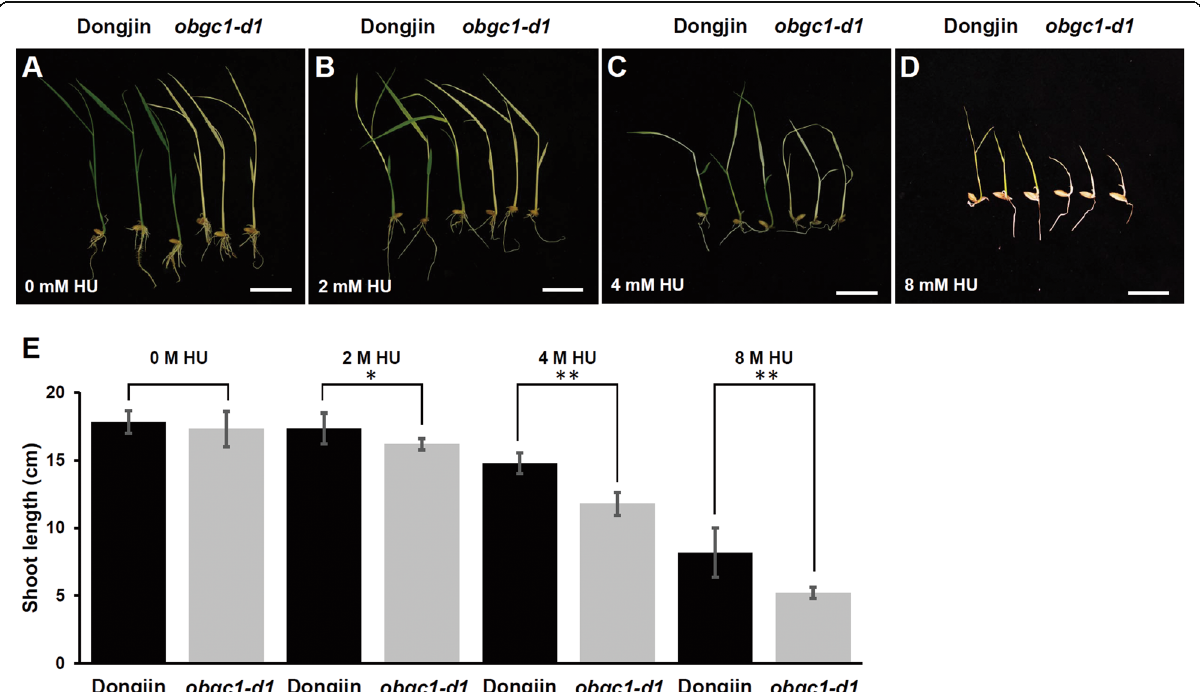
Fig. 3 Responses of wild-type and obgc1-d1 mutant plants to HU exposure. Sensitivity of wild-type (WT) and obgc1-d1 mutant plants upon exposure to increased concentrations of HU (0, 2, 4, and 8 mM) was determined ( A - D ). Shoot length were measured as well ( E ). Seedlings were grown for 10 days in a controlled growth chamber (25 °C, 70% humidity and illumination of 70 – 80 μ mol m − 2 s − 1 white light) with 16 h light and 8 h dark cycle. White scale bars in each growth image represent 4 cm in length. Statistical analysis was conducted by using Student ’ s t-test. * indicates p < 0.5 and ** indicates p <